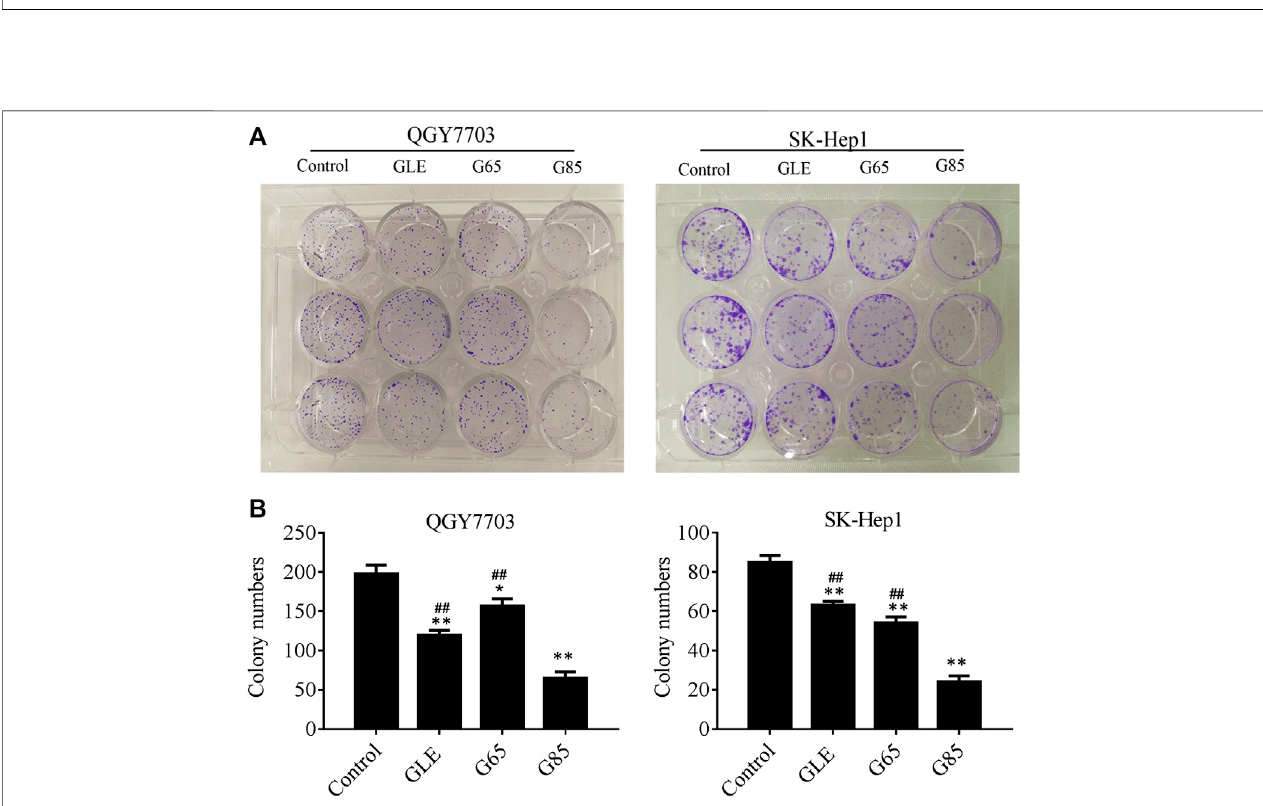
FIGURE 3 | The antiproliferative activity of G. lucidum extracts on human hepatoma carcinoma in vitro . (A) QGY7703 and SK-Hep1 cells were treated with GLE, G65,andG85for12 h,and cultured 14 daystoformcolony. (B) Thecolonynumber ofQGY7703andSK-Hep1 cellstreatedwithGLE,G65,andG85for14 days.Data were shown as mean ± SD ( n (cid:2) 3), * p < 0.05, ** p < 0.01, vs control. # p < 0.05, ## p < 0.01, vs G85.